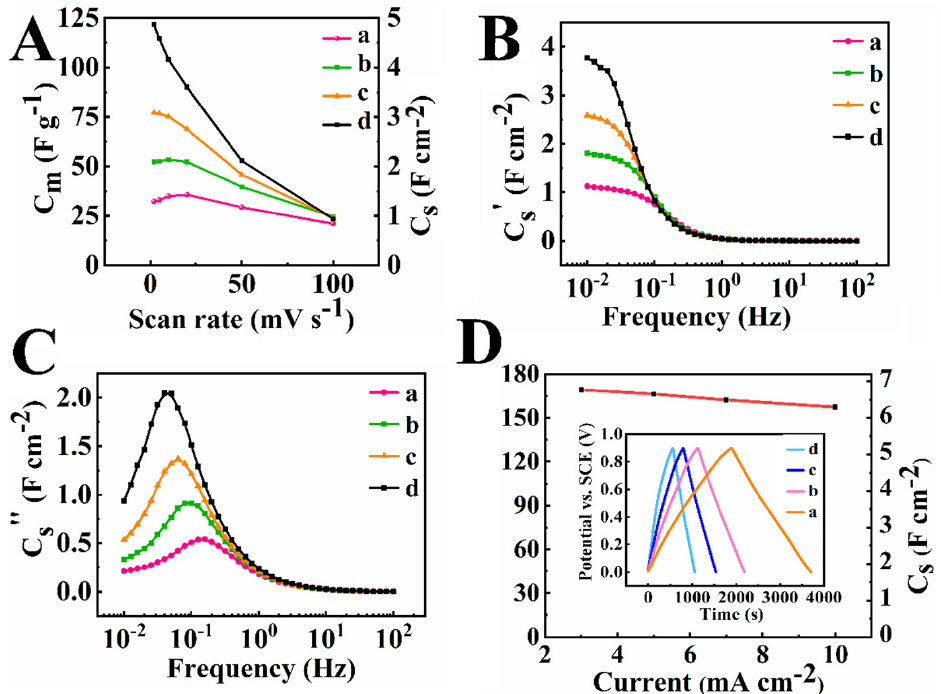
Figure 5. ( A ) Integral capacitances calculated from the CV data, ( B ) real and ( C ) imaginary compo- nents of differential complex capacitances versus frequency, calculated from the EIS data for (a) TP 1, (b) TP 2, (c) TP 3, and (d) TP 5; ( D ) integral capacitance obtained from the GCD data after TP 5 versus current density; inset shows corresponding charge discharge curves for current densities of (a) 3, (b) 5, (c) 7, and (d) 10 mA cm − 2 .